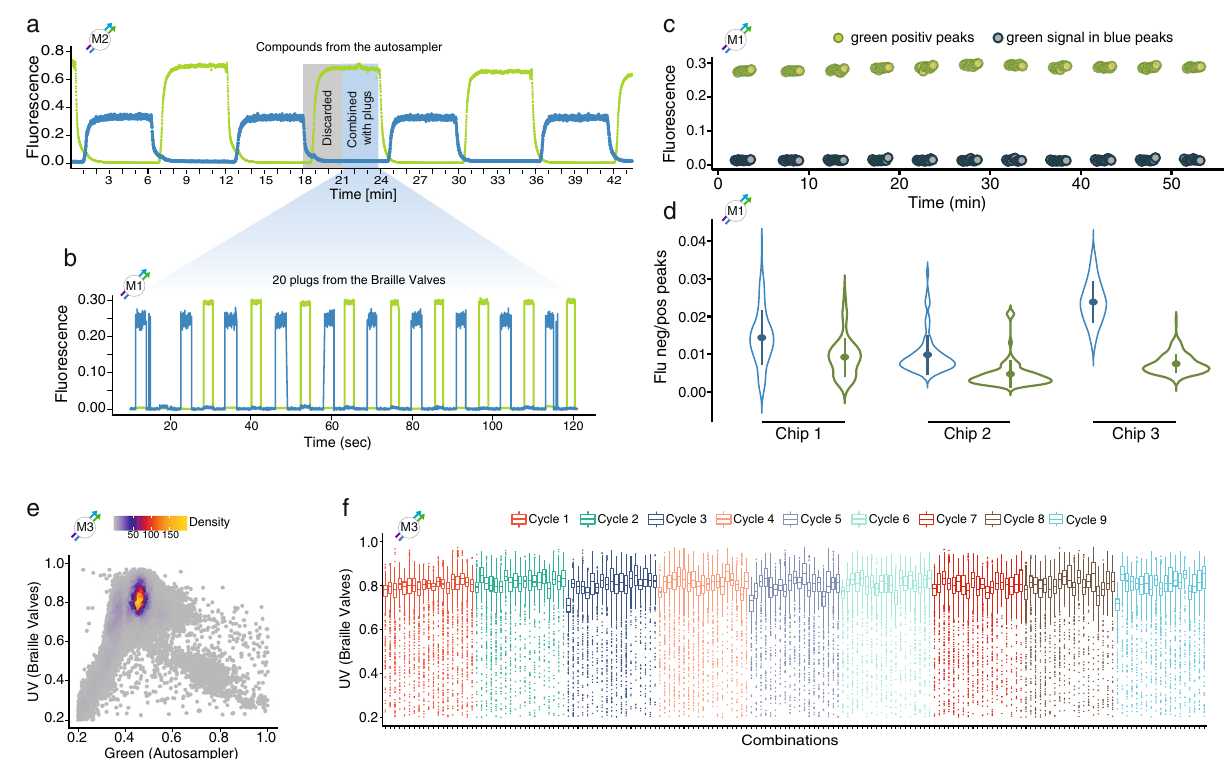
Fig. 2 | Validations of the micro fl uidic pipeline. a Alternating injection of Alexa- 488 or Cascade-Blue from a 96-well plate using the autosampler. Samples being injectedinthetimewindowofdecreasingandincreasing fl uorescencesignals(grey box) were discarded by ensuring no combinations were generated. Since no drug- barcode plugs from the Braille display were injected during time windows with unstable concentrations (grey box), droplets only contained non-functional bar- codes (BC-PCR). Time windows with stable fl uorescence signals (blue box) were used to generate drug combinations by the co-injection of 20 plugs generated on the Braille display chip resulting in functional barcodes. b Fluorescence intensities of a plug-sequence from the Braille valves supplemented with either Alexa-488 or Cascade-Blue measured at position M1 (=before combinatorial mixing). The blue overlayconnecting( a )and( b )illustratesatimeseriesduringwhichonecycleof20 plugs (second plug without reference dye) is combined with one sample from the autosampler. Alternating sequences of drugs supplemented with Cascade-Blue or Alexa-488wereusedtoquantifycross-contaminationbetweenspeci fi c(e.g.,green) fl uorescent-positiveplugsintothesubsequentnegative(e.g.,blue)sampleforboth